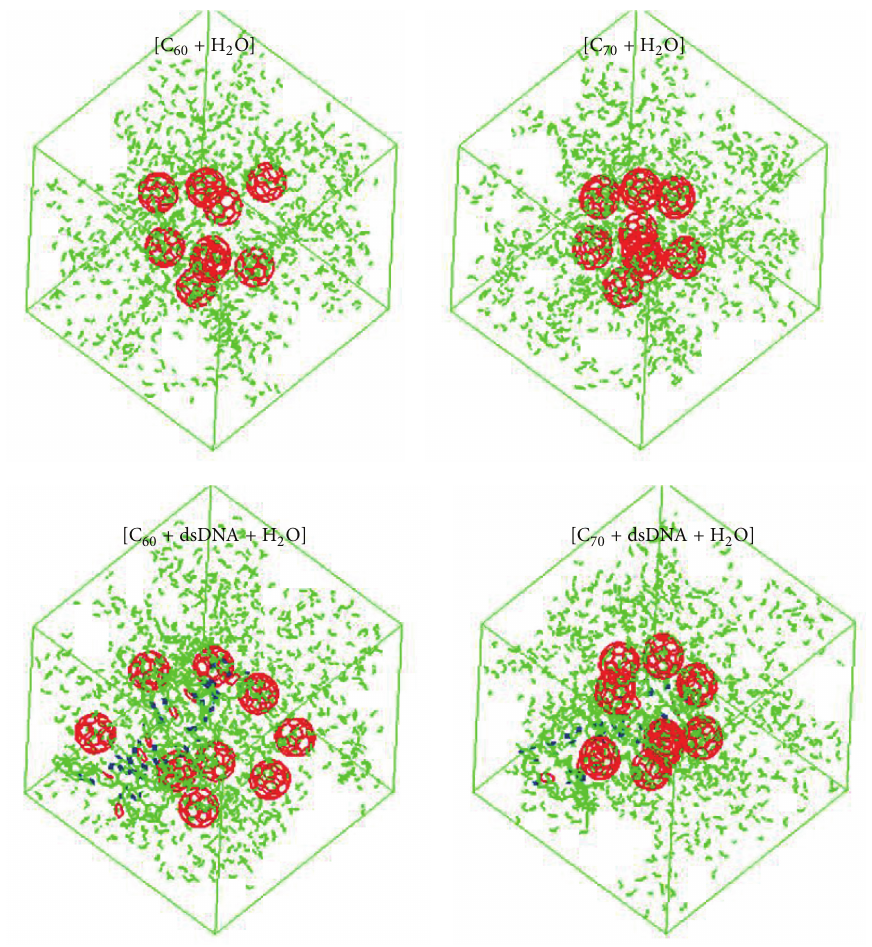
Figure 3: Perspective snapshot for the dispersion state of the fullerene agglomerate in the [fullerene + H 2 O] binary systems and [fullerene + dsDNA + H 2 O] ternary systems after 100000 simulation steps.